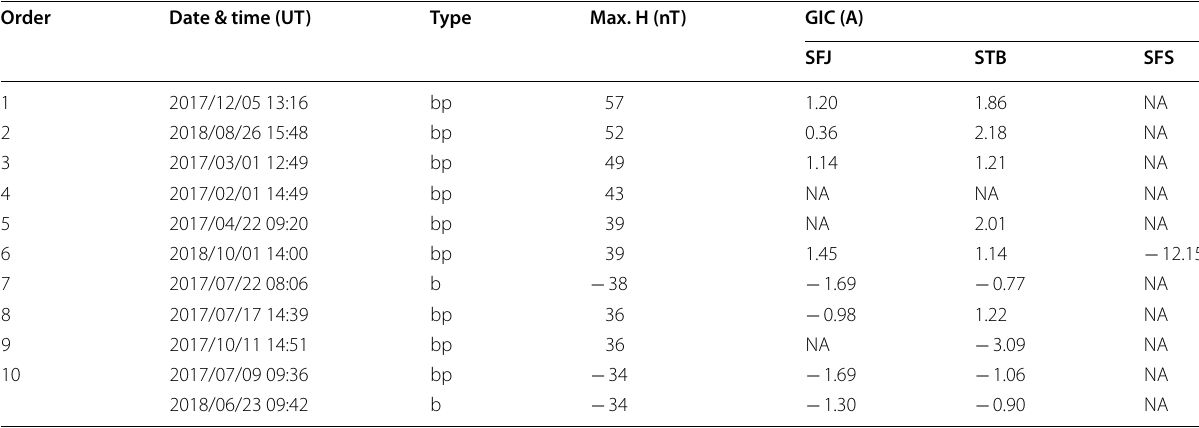
Table 5 Bay disturbances with largest values of H-component geomagnetic field reported from KAK and maximum GICs